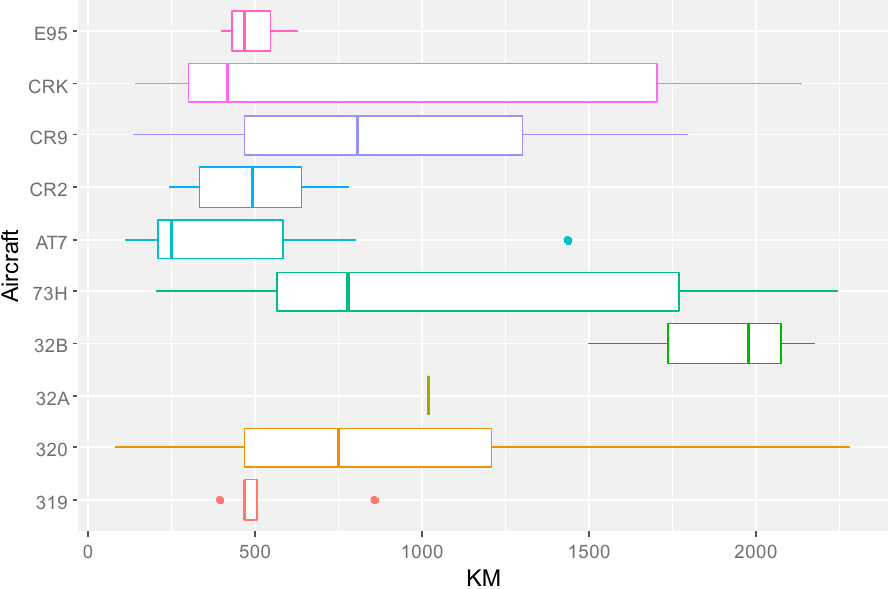
Figure 4. Overall fleet performance. Source: own elaboration from data published by [19].